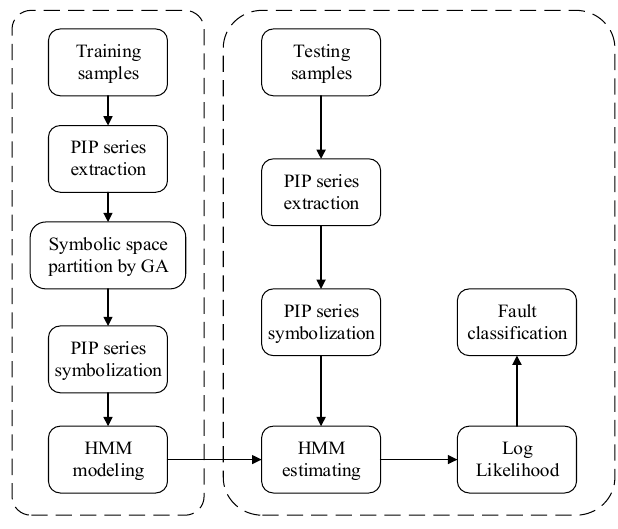
Figure 8. Hydraulic pump fault diagnosis framework.